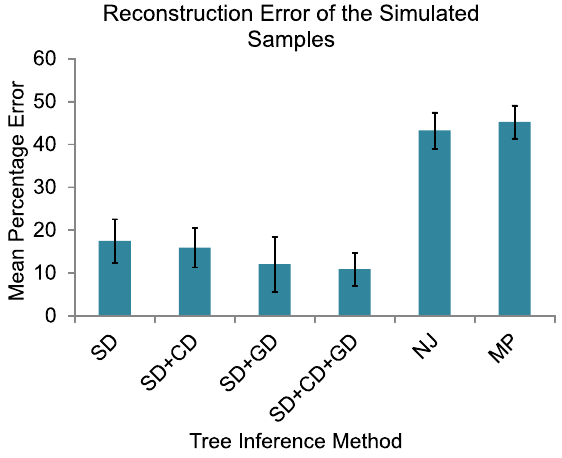
Figure 4. Accuracy of phylogenetic inference on simulated copy number data for varying algorithms. Variants of our phylogenetic algorithms and two competing methods from the literature were applied to simulated FISH datasets describing evolution by combinations of single-gene (SD), chromosome (CD), and whole- genome (GD) duplication and loss events. Results are reported for inference by our methods from 100 simulated trees, allowing for SD events alone, SD + CD events, SD + GD events, and SD + CD + GD events. We compared these results to inference by neighbor-joining (NJ) and pure maximum parsimony (MP) as implemented in MEGA, version 6. Accuracy is assessed by mean reconstruction error of bipartitions between true and inferred trees. Error bars show plus or minus one standard deviation across the samples for each method.